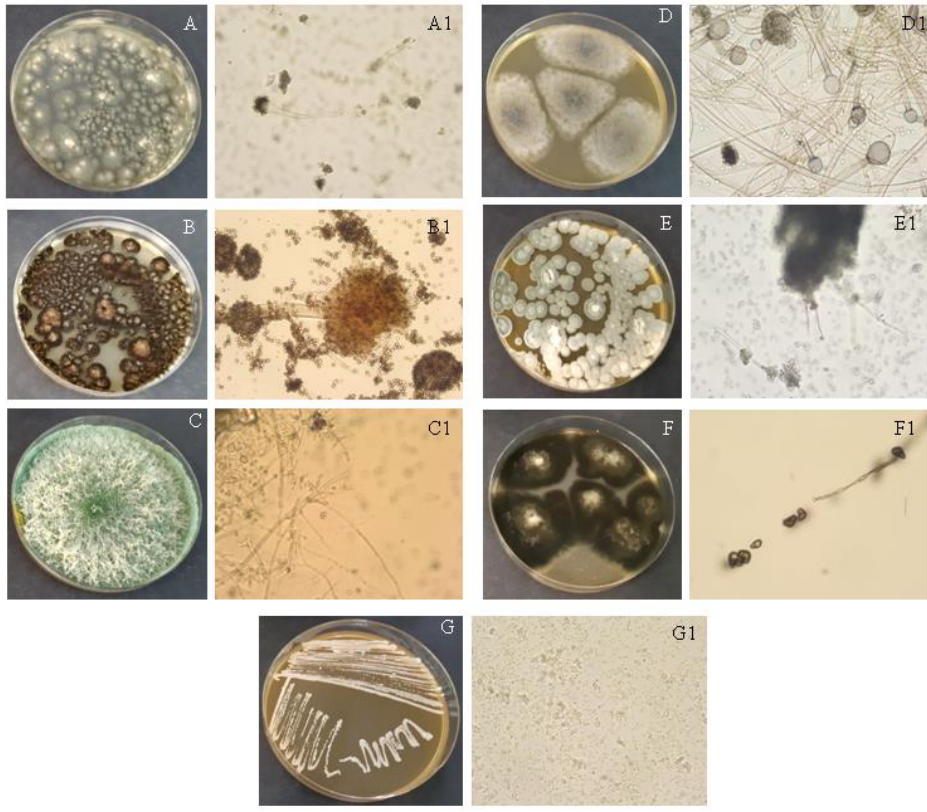
Figure 3. Obtained pure culture by streaking method and microphotographs of fungi isolates I9 ( A , A1 ), I10 ( B , B1 ), I11 ( C , C1 ), I12 ( D , D1 ), I13 ( E , E1 ), I14 ( F , F1 ), and I15 ( G , G1 ), M = 400×.